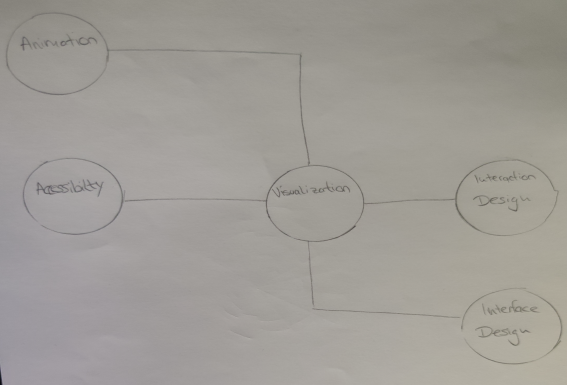
Figure 12. Node-link diagram for exploration starting from one